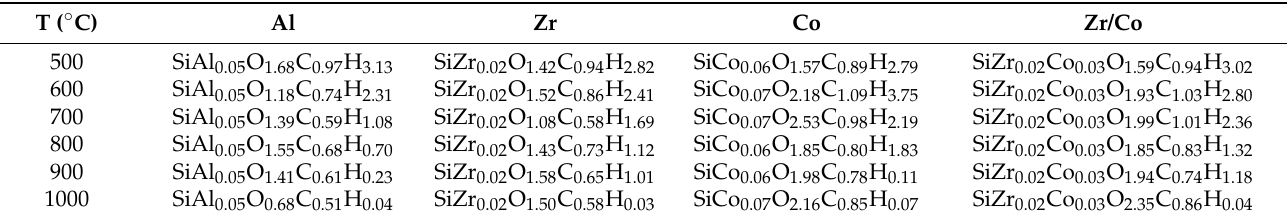
Table 1. Chemical composition of the studied materials (deviation ±0.05).